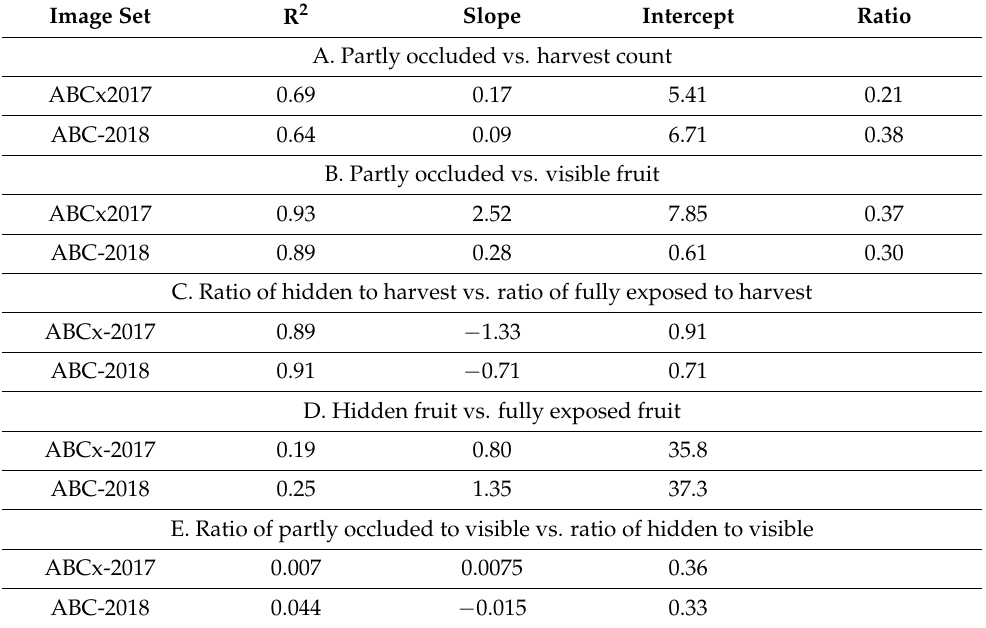
Table 9. Statistics for linear correlations between combinations of attributes related to the number of partly occluded fruit, non-occluded and hidden (fully occluded) fruit per tree, for image sets ABCx-2017 and ABC2018: (A) count of partly occluded fruit regressed on harvest count of fruit; (B) count of partly occluded fruit regressed on number of visible fruit; (C) ratio of count of hidden fruit to harvest count regressed on ratio of count of fully exposed fruit to harvest count; (D) count of hidden fruit regressed on count of fully exposed fruit; and (E) ratio of count of partly occluded fruit to count of visible fruit regressed on ratio of count of hidden to count visible fruit. For a given tree, harvest count is equivalent to the sum of hidden (fully occluded), partly occluded and fully exposed (non-occluded) fruit, while visible fruit is the total MangoYOLO count for a tree, equivalent to the sum of partly occluded and fully exposed fruit.